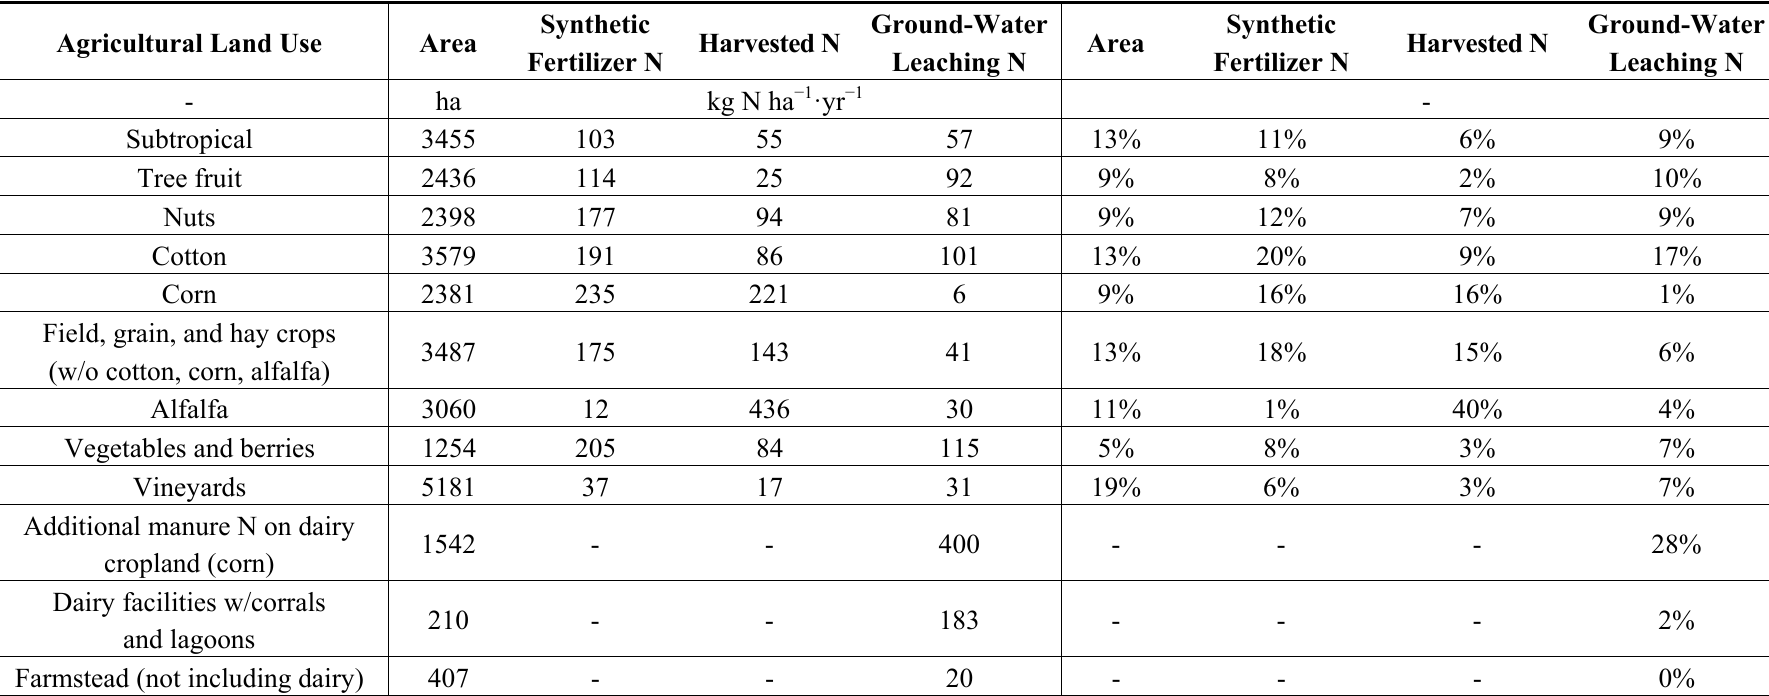
Table 5. 2008 N fertilizer applied and estimated leachate per hectare within 1000 m buffer zone around a DAC or SDAC census designated